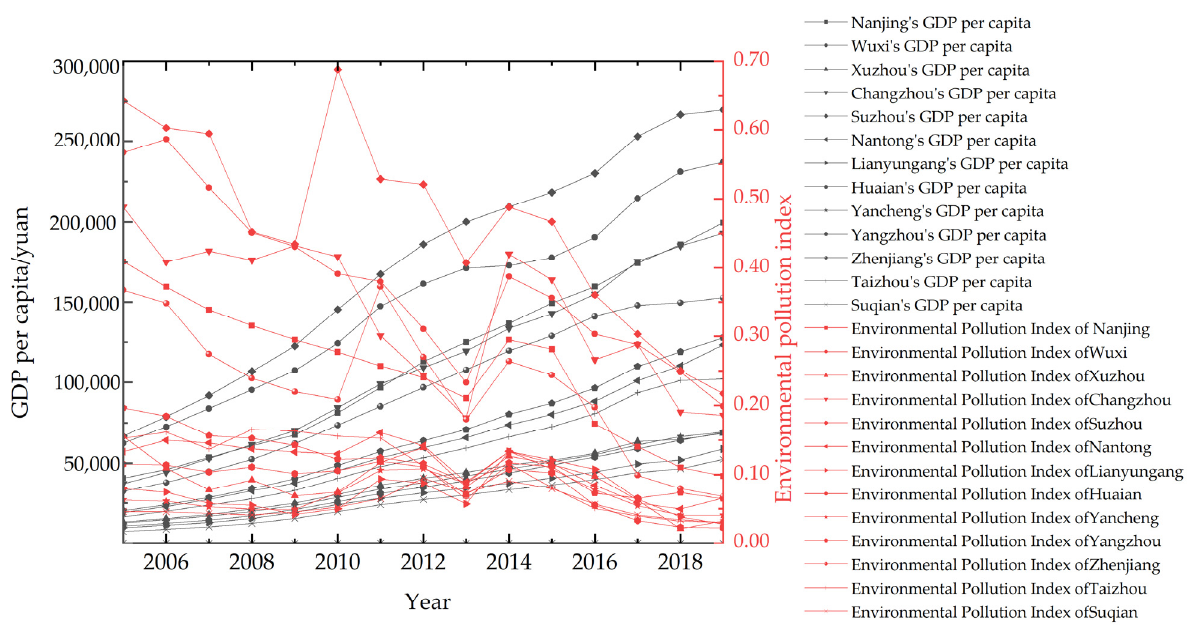
Figure 7. GDP per capita and environmental pollution index of cities in Jiangsu province, 2005– 2019.